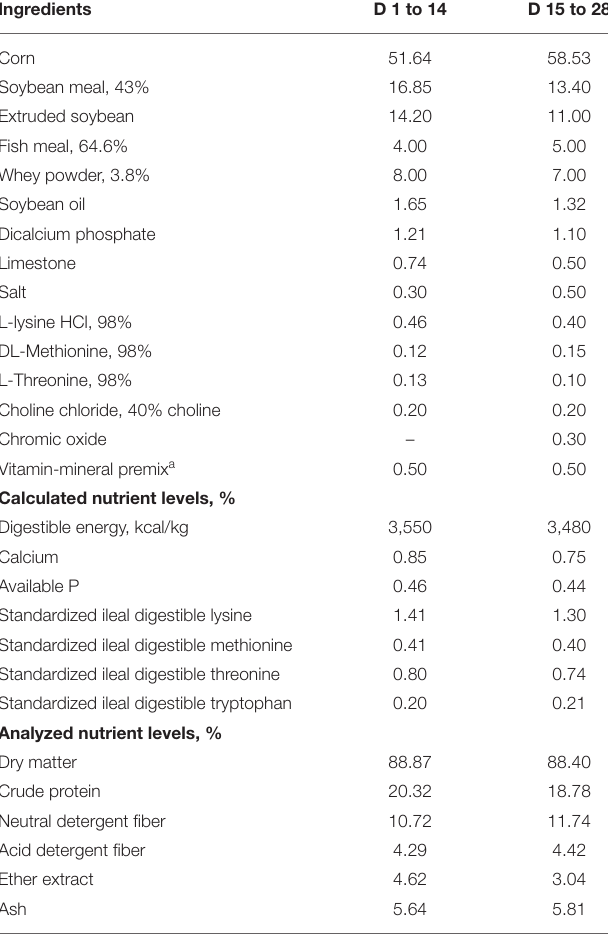
TABLE 1 | Composition and nutrient levels of the basal diets (%, as-fed